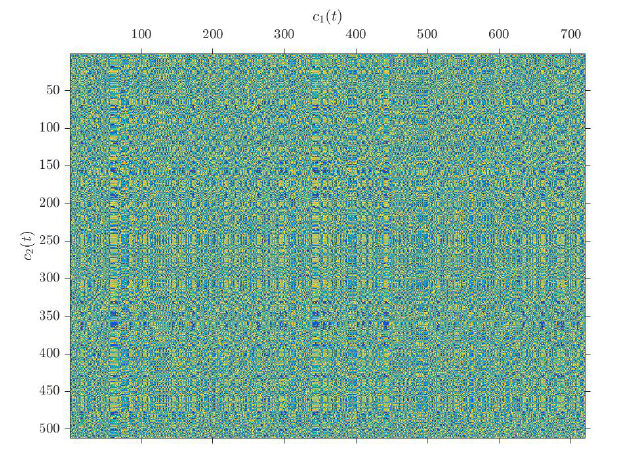
Figure 3. 2D Crossed Chaotic Signal.